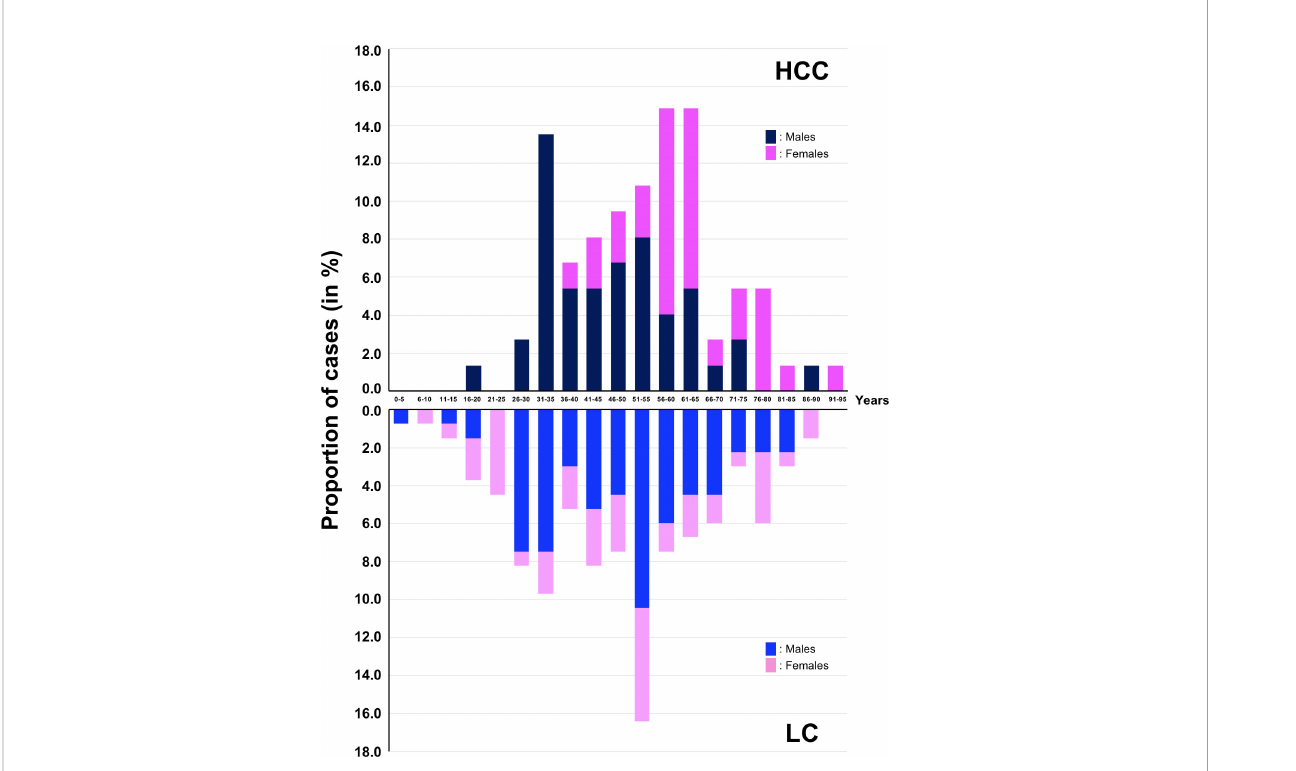
FIGURE 1 Distribution of HCC and LC cases according to